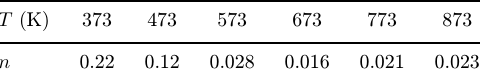
Table 1. Temperature dependence of the frequency exponent \ n ".